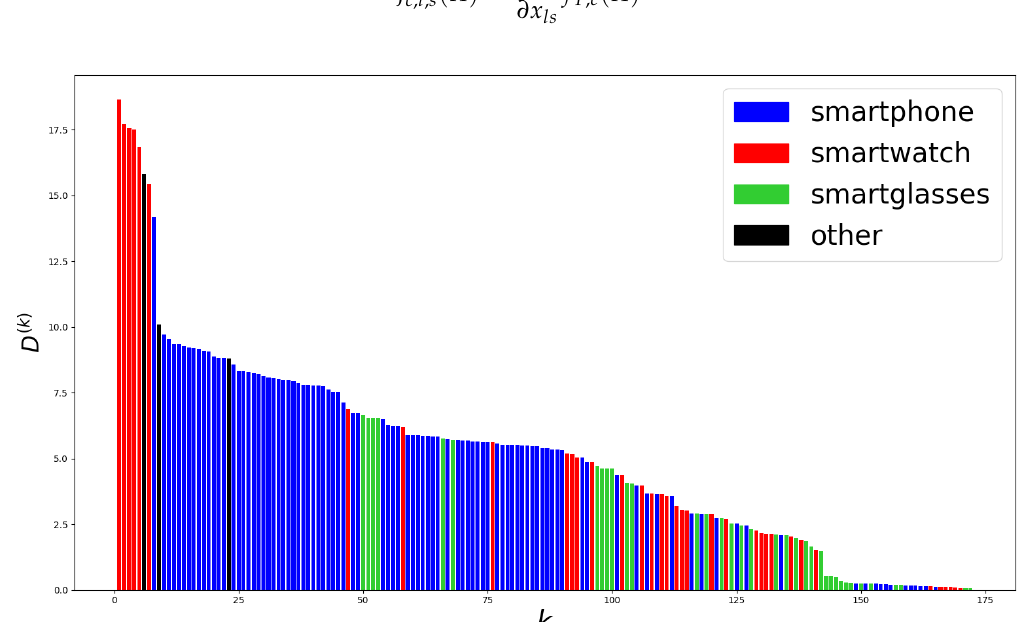
Figure 5. Layer differences D ( k ) for all layers of mDNNs trained using TTO and CNN-transfer for BBH classification on the CogAge dataset. Each bar corresponds to a layer and represents its difference between TTO and CNN-transfer. Layer differences are arranged in decreasing order. For each of them, we indicate if it was computed for a layer belonging to a branch processing smartphone, smartwatch, or smartglasses data. Layers not belonging to any branch (e.g., concatenation or fully-connected layers) are categorised as